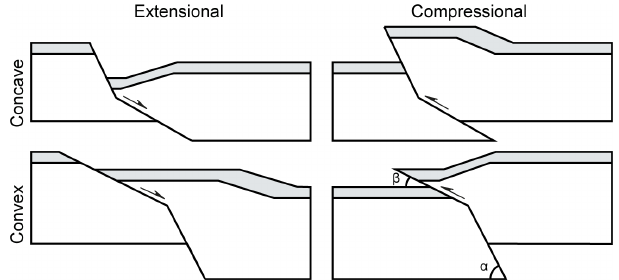
Figure 1. Cartoons illustrating concave and convex (to the hang- ingwall) fault bends and the associated hangingwall deformation in extensional and compressional tectonic